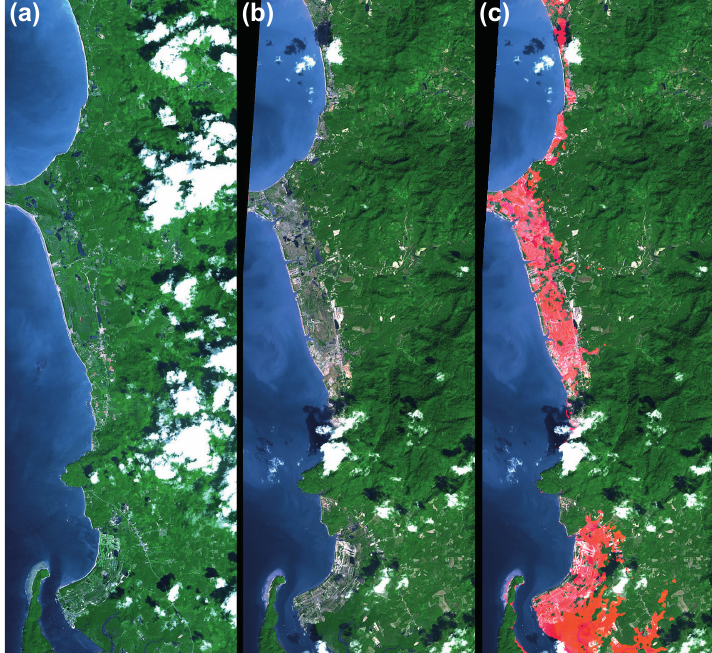
Figure 4. Images of Khao Lak in Thailand before and after the 26 December 2004 Indian Ocean tsunami. ( a ) Pre-event Advanced Spaceborne Thermal Emission and Reflection Radiometer (ASTER) image (15 November 2002). ( b ) Post-event ASTER image (31 December 2004). ( c ) ASTER image with Shuttle Radar Topography Mission (SRTM) Elevation range mask within 10m of Sea Level. Image credits: ASTER: NASA/GSFC/METI/ERSDAC/JAROS, and U.S./Japan ASTER Science Team SRTM: NASA/JPL/NGA. Available at: